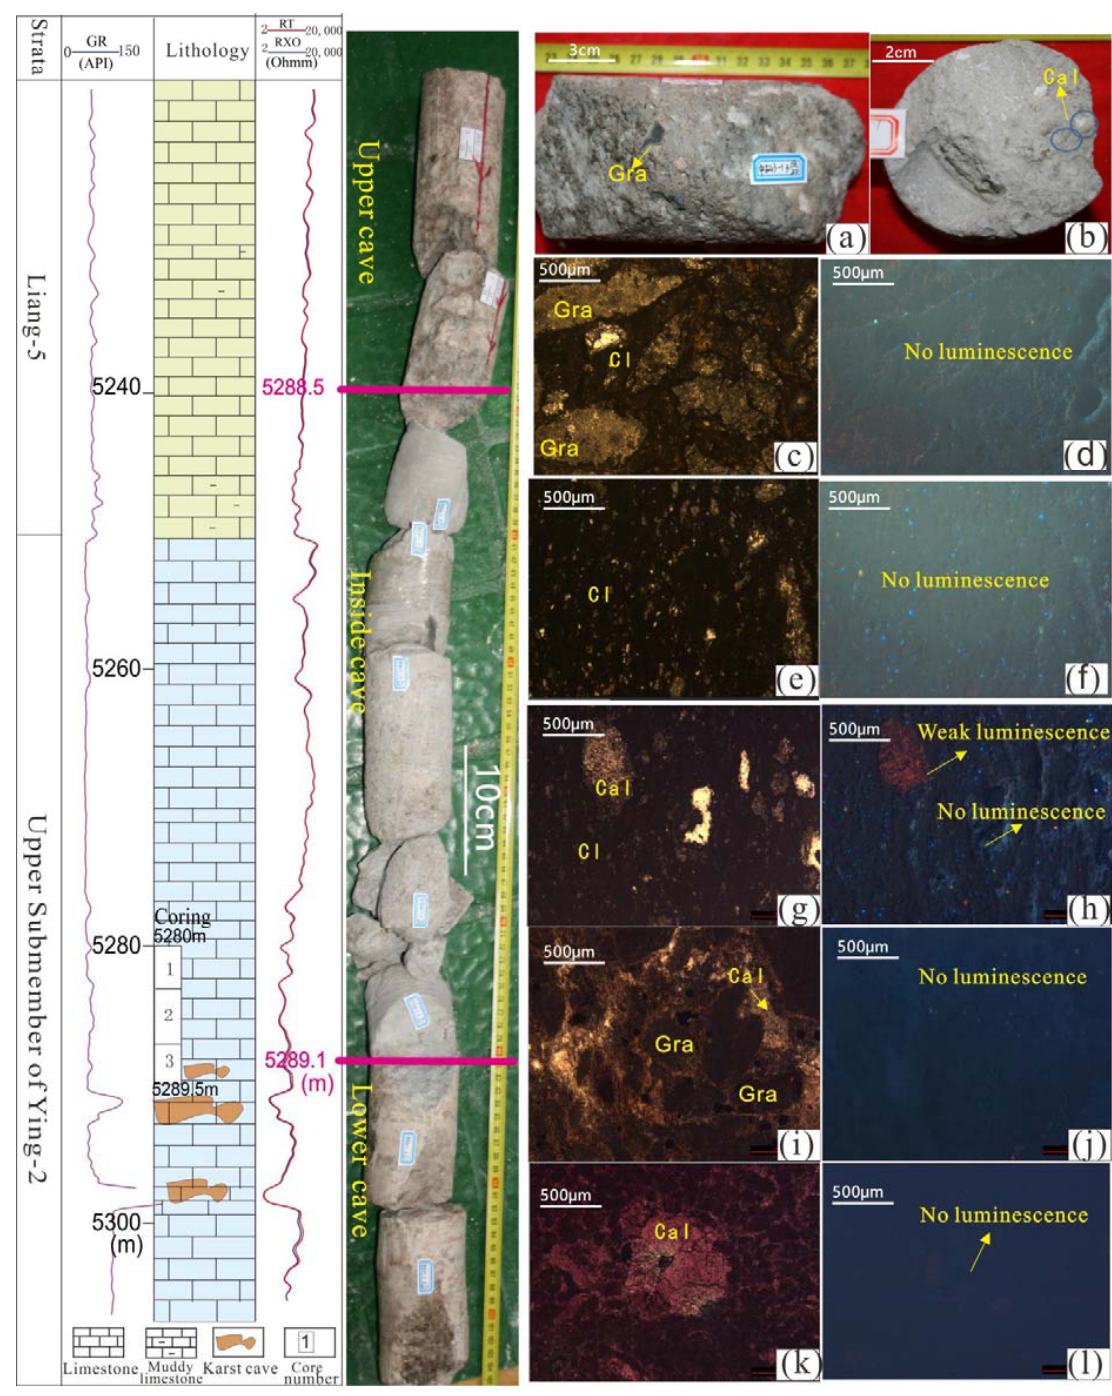
Figure 5. The petrological characteristics of karst pore and cave fillings of the Yingshan Formation in Well LG43-1. ( a , b ) Karst cave fillings show limestone gravel (Gra), clay (Cl), and calcite (Cal), and the fillings are relatively soft; ( c , e , g , i ) limestone debris grains (Gra), clay (Cl), calcite (Cal), and karst caves. Generally, fillings in karst caves do not show luminescence ( d , f , h , j ) and minor karst caves do not show luminescence ( h ), 5288.5–5289.1 m; ( k , l ) calcite in pores in the lower part of karst caves did not show luminescence, 5289.2 m.